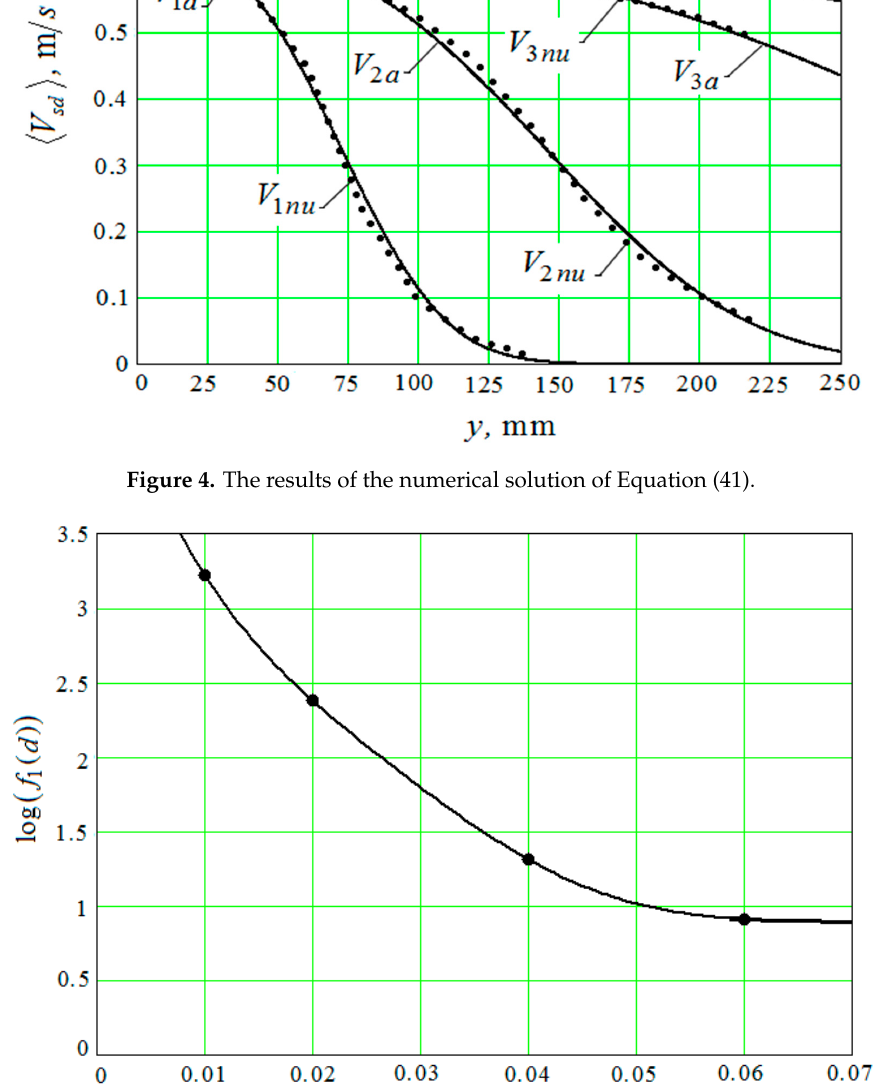
Figure 6. The function ( )2 f d (continuous curve) and the results of the numerical solution of Equation (41) (points). The root-mean-square relative deviation of the values that were calculated by the Equation (42) from the values obtained by the numerical solution of the Equation (41) is less than 6%.